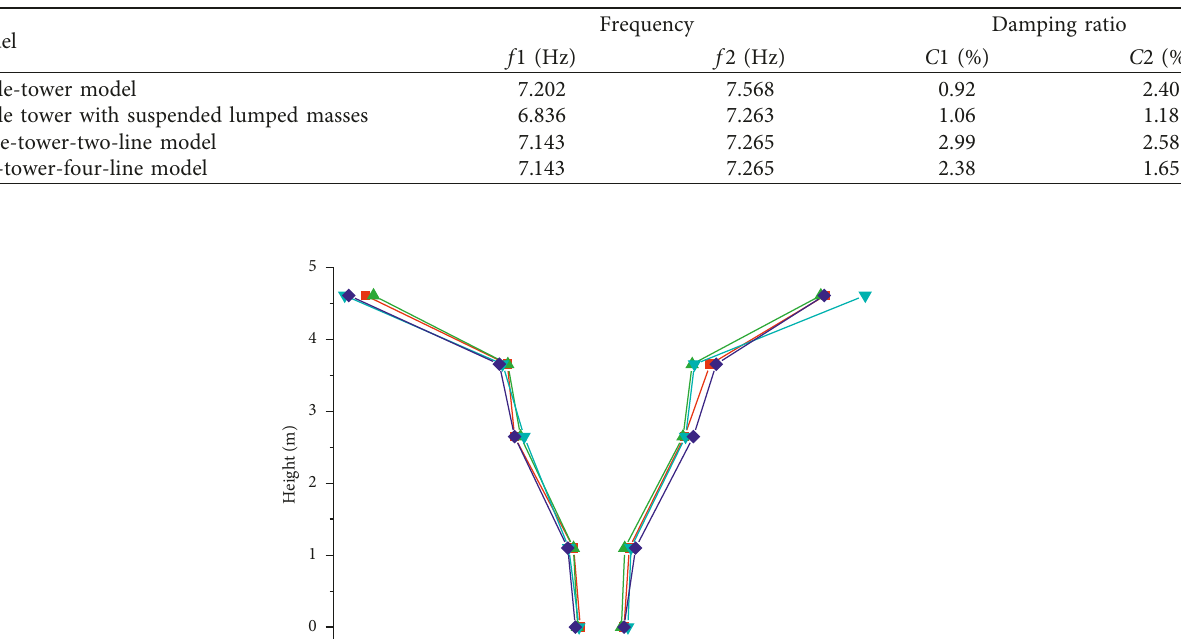
Figure 21: Spectrum analysis curves of the middle towers of the four counterweight models. (a) First-order frequency spectrum analysis curves. (b) Second-order frequency spectrum analysis curves. Table 4: Comparison of the basic dynamic characteristics of the middle towers of the four models.